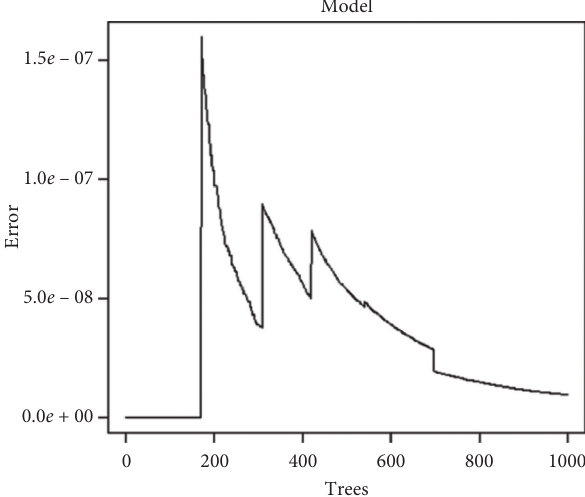
Figure 3: Representation of the prediction error using Random